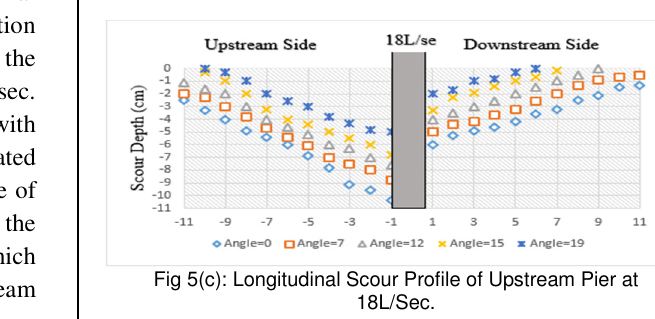
Fig 5(b): Longitudinal Scour Profile of Upstream Pier at 14L/Sec.